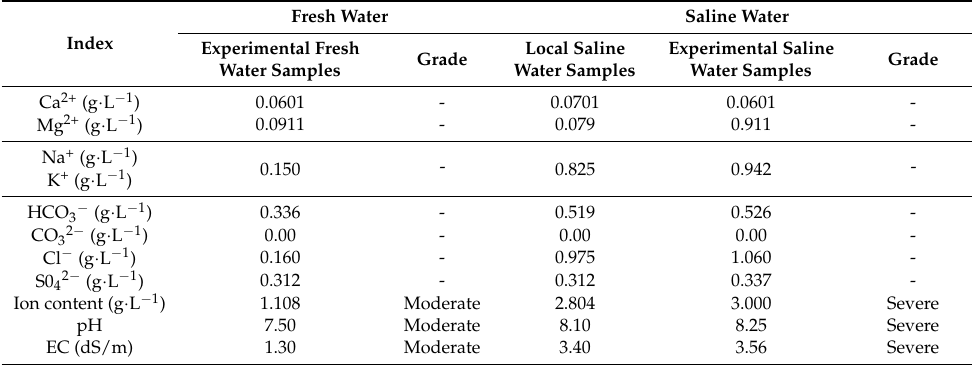
Table 2. Water quality analysis of experimental